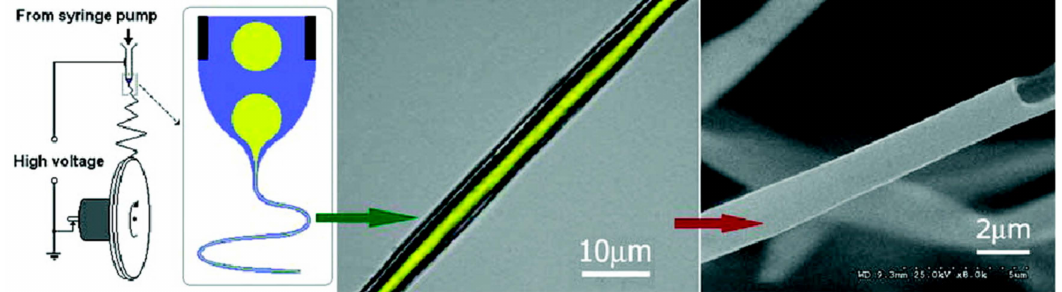
Figure8. ThesetupbyBazilevskyandcolleaguesforthefabricationofsinglenozzlecoaxialelectrospinning of polyacrylonitrile (PAN) and poly(methyl methacrylate) (PMMA) using Dimethylformamide (DMF) as a solvent. PAN forms the core while PMMA forms the sheath of the polymer. Reprinted with permission from [46], American Chemical Society,